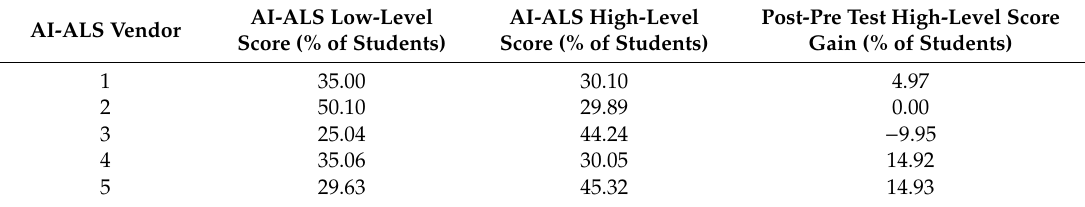
Table 1. Comparisons between scores within the five AI-ALS and the paper-based